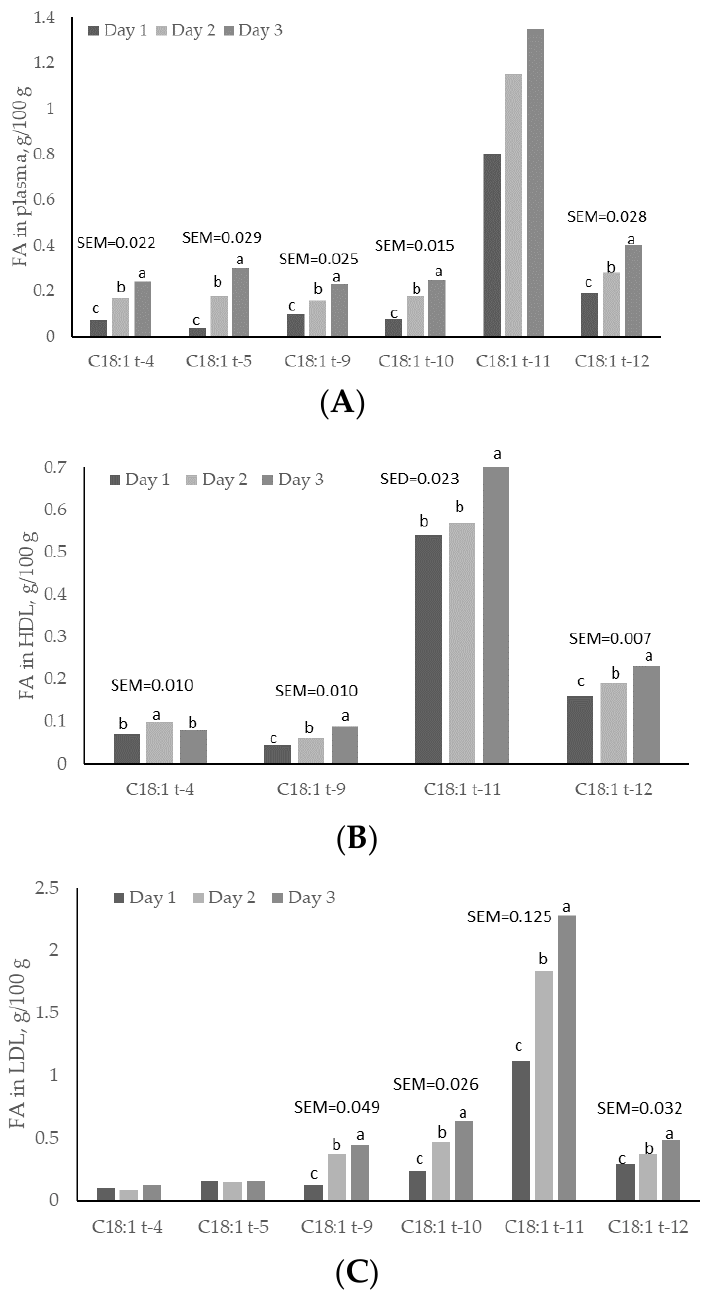
Figure 2. Day variations of C18:1 trans fatty acids (FAs) in ( A ) total plasma; ( B ) high-density lipoprotein (HDL) and ( C ) low-density lipoprotein (LDL) fractions from cows subjected to ruminal pulses of control, partially hydrogenated vegetable oil and soybean oil. SEM = standard error of the mean. a,b,c Means with different superscripts differ significantly ( p < 0.05). Pooled means of control, partially hydrogenated vegetable oil and soybean oil per day are shown. p -value represents the effect of sampling day.